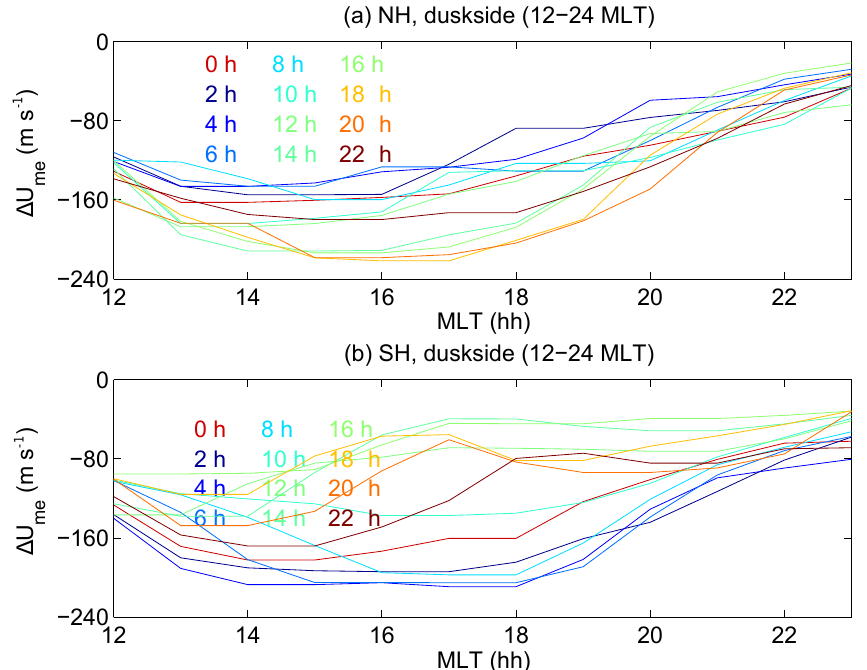
Figure 5. The MLT variation of the strongest disturbance westward neutral winds driven by SAPS. Different colors represent SAPS onset times from 00:00 to 22:00UT at 2h intervals. The top panel is in the Northern Hemisphere, and the bottom one in the Southern Hemisphere.